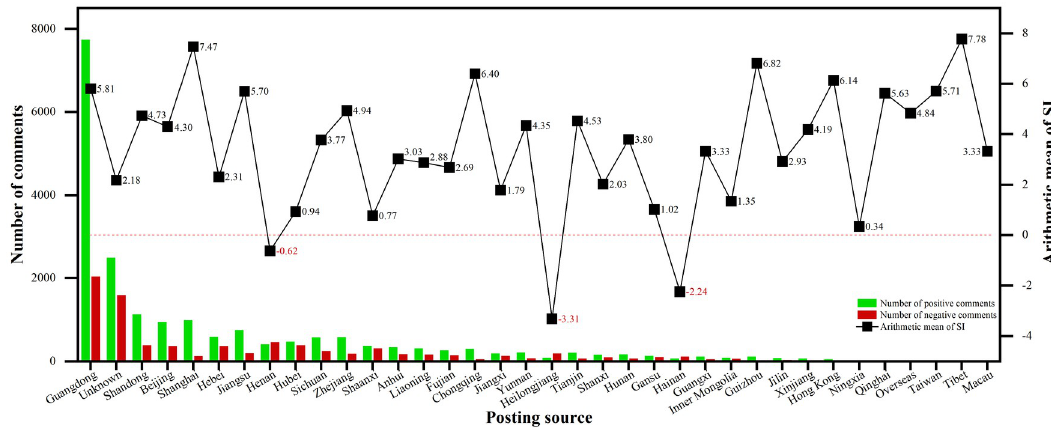
Fig 7. Regional distribution of sentiment classification and arithmetic mean of